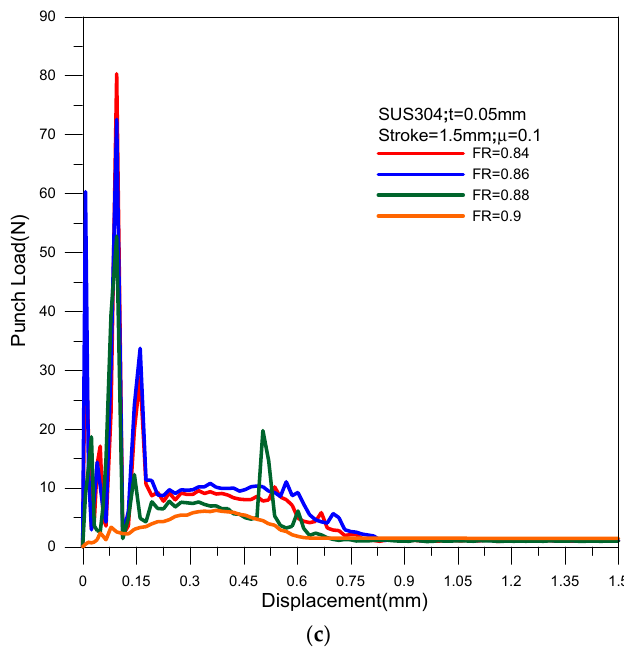
Figure 14. The relationship between the load and stroke of the punch with different FR : ( a ) Model 1; ( b ) Model 2; ( c ) Model 3.